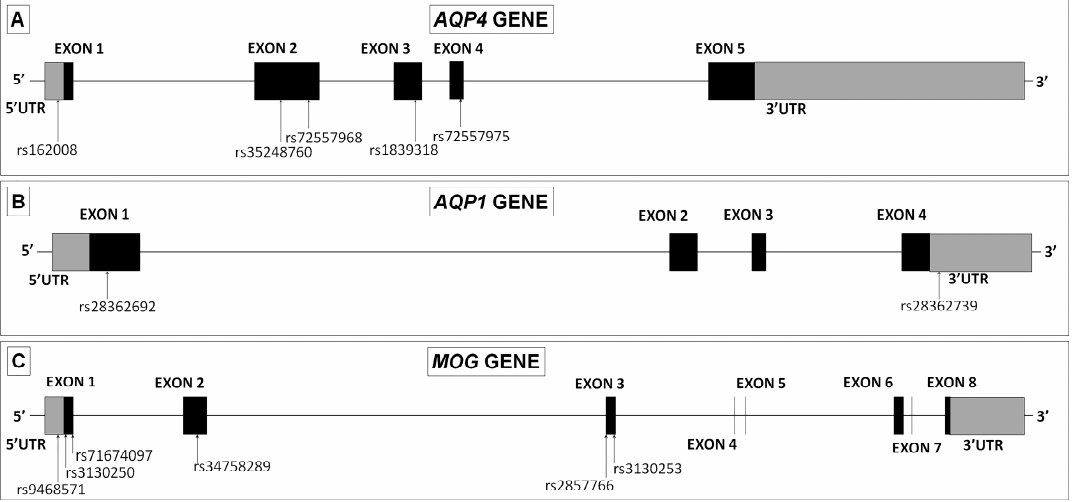
Figure 5. Squeme of exons organization in AQP4, AQP1 and MOG genes. Different variants found per each gene in NMOsd(+) patients.